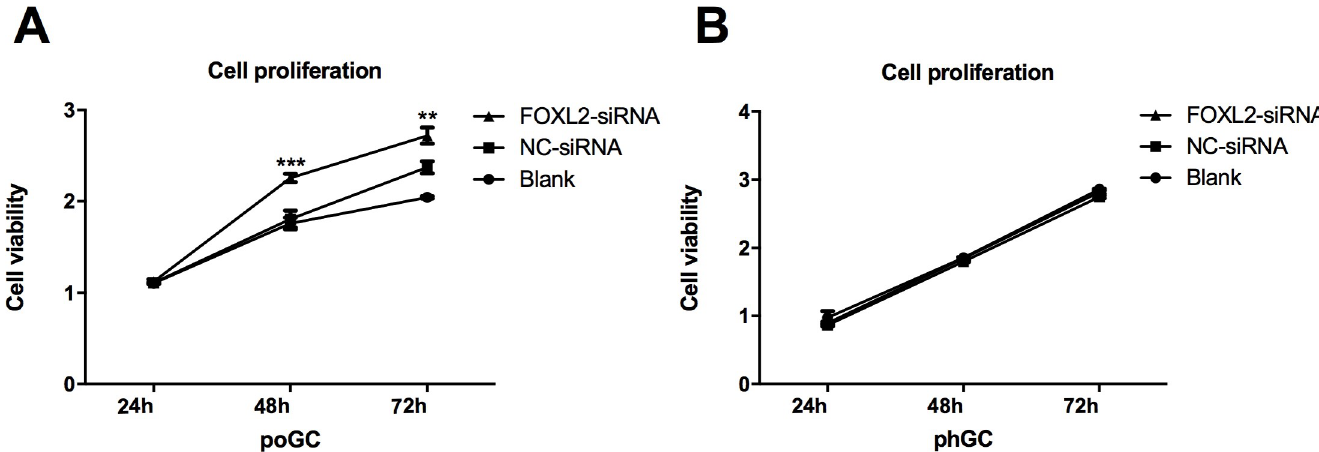
Fig 6. The effect of FOXL2 knockdown on chicken granulosa cell proliferation. Chicken granulosa cells were transfected with FOXL2-siRNA, and two control groups were used: NC-siRNA and a blank (not transfected). Cell proliferation was measured using Cell Counting Kit-8 24, 48, and 72 h post-transfection. All values are represented as the mean ± SD of three independent experiments repeated in triplicate. The asterisks represent statistically significant differences ( �� indicates P < 0.01, ��� indicates P < 0.001). (A) FOXL2-silencing in poGC promoted cell proliferation. (B) FOXL2-silencing in phGC had no effect on cell proliferation.